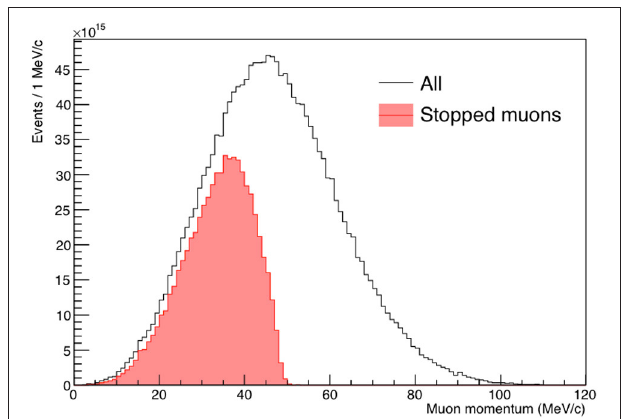
FIGURE 4 | Charge selection in the central Mu2e collimator. Red µ − are bent upwards; µ + are bent down and strike the collimator in this Figure; the experiment will deflect in the opposite direction from what is shown here. From Bartoszek et al. [8].